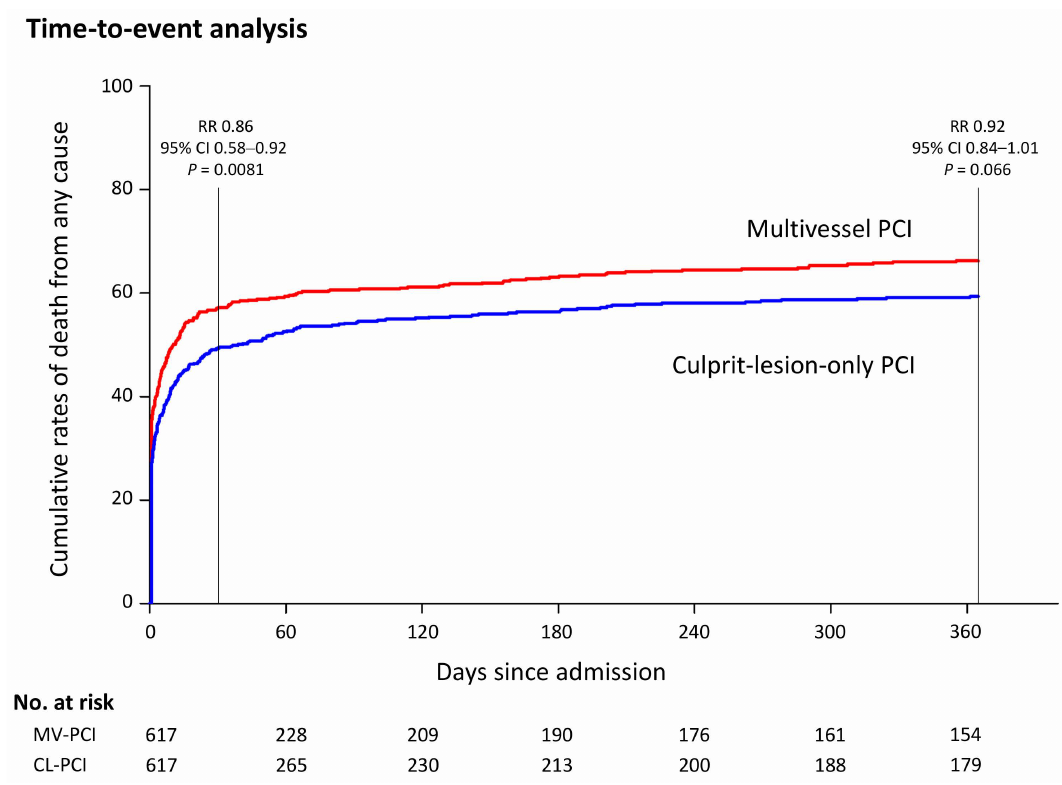
Figure 2. Event rates of the death from any cause at 12 months in study groups. Abbreviations: CI = confidence interval; CL = culprit-lesion-only; HR = hazard ratio; MV = multivessel; PCI = percutaneous coronary